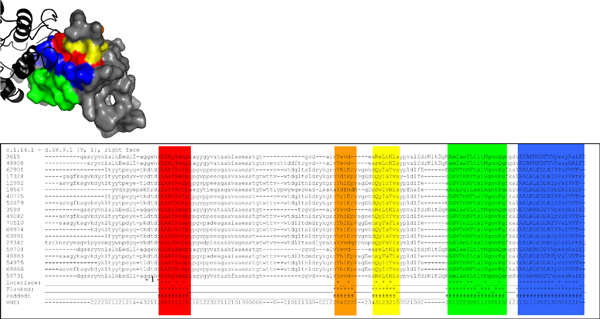
A sample alignment for RuBisCo N-terminal domain. Interacting segments are highlighted in corresponding colors in the alignment as well as in the structure. Interface segment definition is illustrated by the three lines below the alignment. Finally, the 10 fold von Neumann entropy is printed.